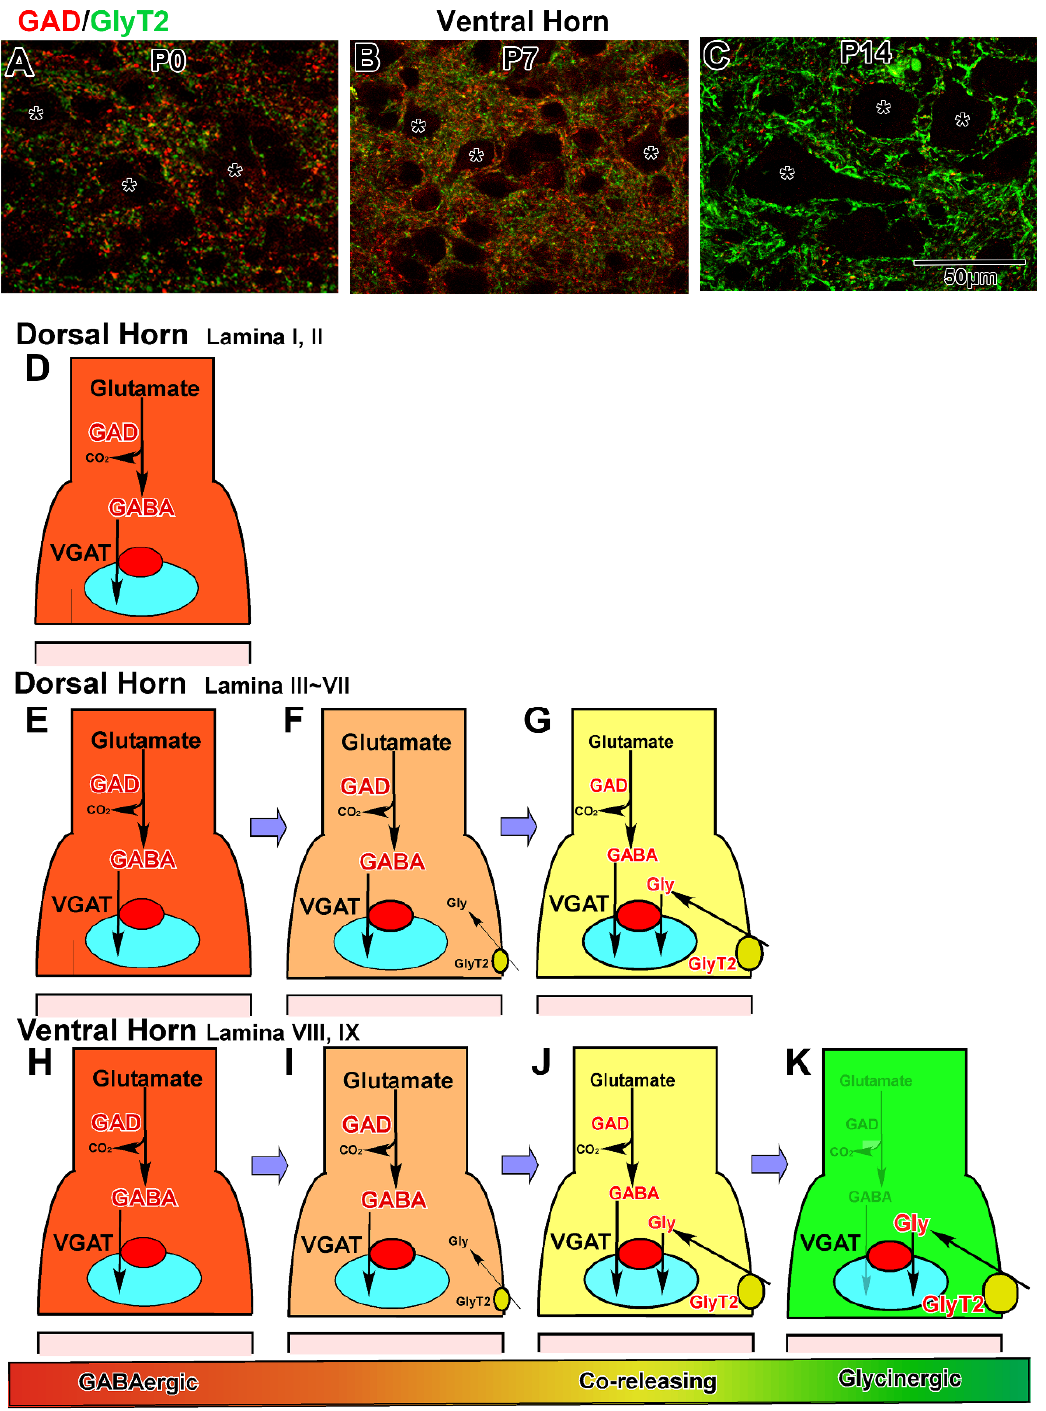
Figure 4. Developmental changes in inhibitory terminals in the spinal cord. ( A – C ) Double labeling of GAD and GlyT2 in the developing ventral horn. Dominant inhibitory terminals are GABAergic (red) at P0 ( A ) and change to coreleasing terminals at P7 ( B ) and glycinergic terminals at P14 ( C ). ( D – K ) Schematic illustrations of the developmental changes in inhibitory terminals. Initially, GABAergic terminals are formed after starting GABA synthesis by GAD in the gray matter ( D , E , H ). In lamina I and II, GABAergic terminals remain ( D ). In lamina III to IX, GABAergic terminals convert to coreleasing terminals by the additional glycine reuptake by GlyT2 ( F , G , I , J ). In lamina VIII and IX, GAD disappears from the terminals, and the coreleasing terminals give rise to glycinergic terminals ( K ).